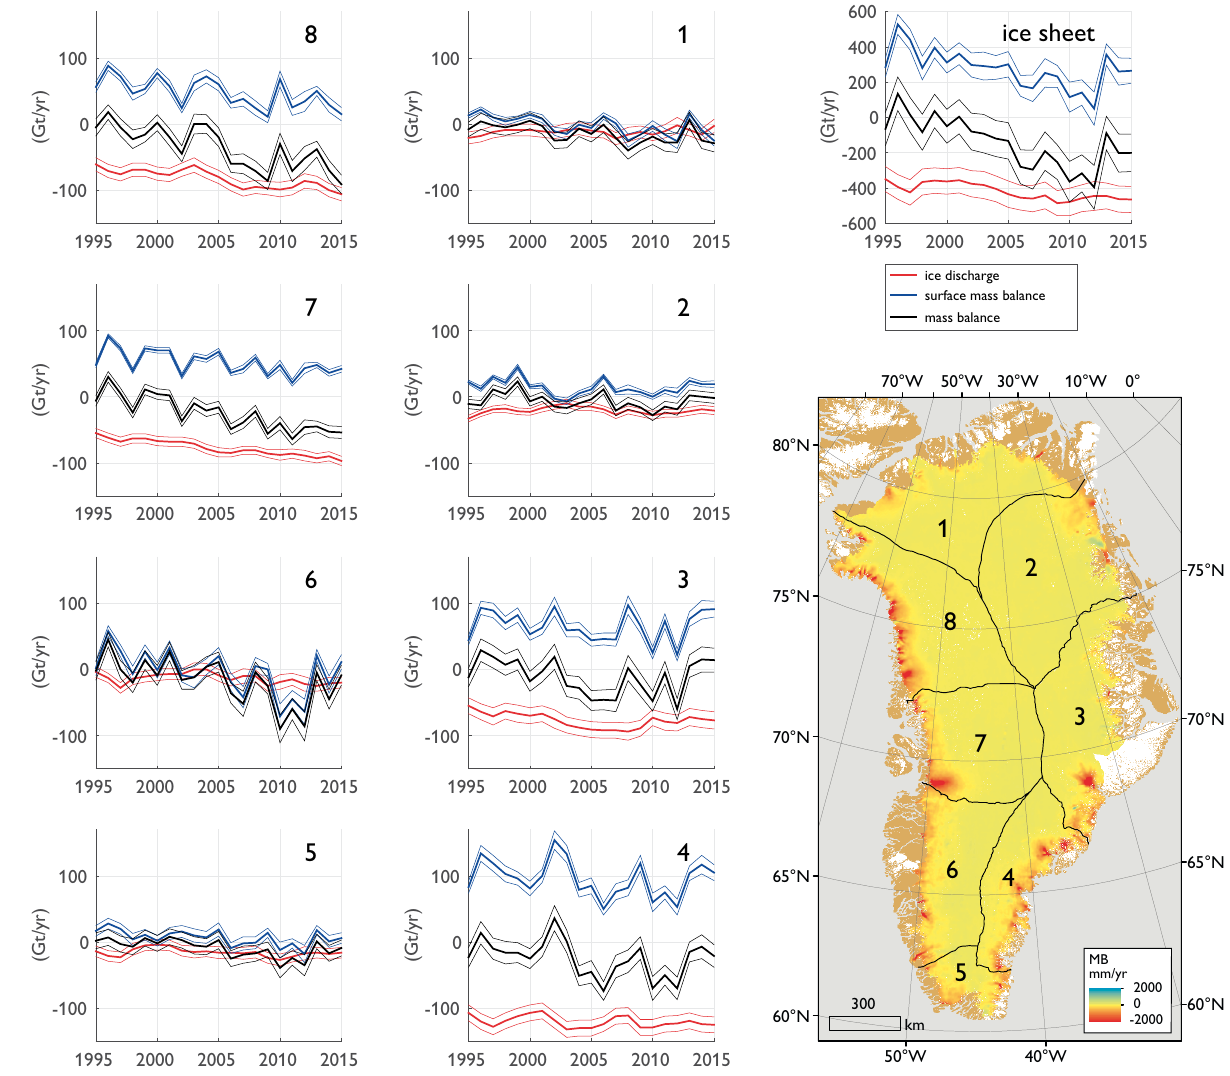
Fig. 4. Annual surface mass balance, ice discharge and mass balance in eight major ice-sheet sectors ( 1–8 ), as well as for the entire ice sheet, over the 1995– 2015 period. Vertical spread denotes associated uncertainty. Map: Spatial distribution of the average 1995–2015 mass balance ( MB ) within the PROMICE ice-sheet mask (Citterio & Ahlstrøm 2013; Khan et al . 2016). Black lines denote the eight major ice-sheet sectors (Zwally et al .